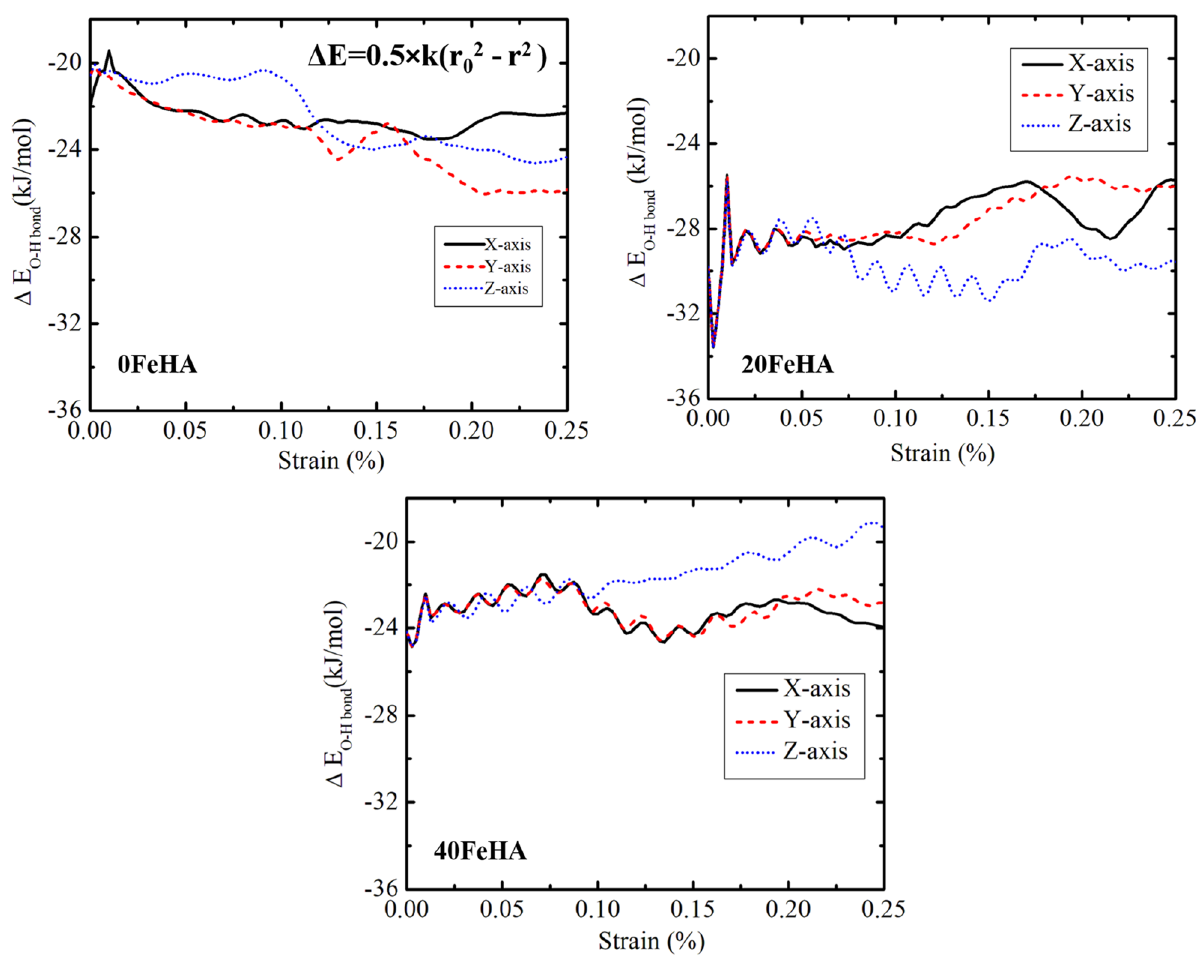
Figure 16. MD simulation analyzed changes in vibrational energy of O–H bonds for Fe-doped HA at T = 10 K. (Sample designation: xFeHA means x mol% Fe 2+ -doped